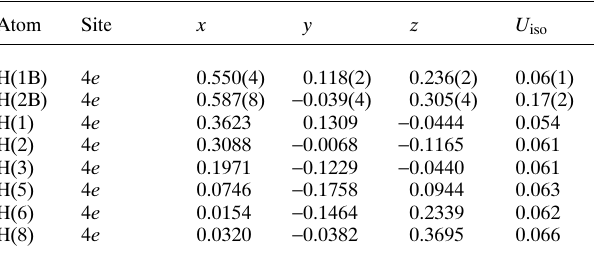
Table 2. Atomic coordinates and displacement parameters (in Å 2 )